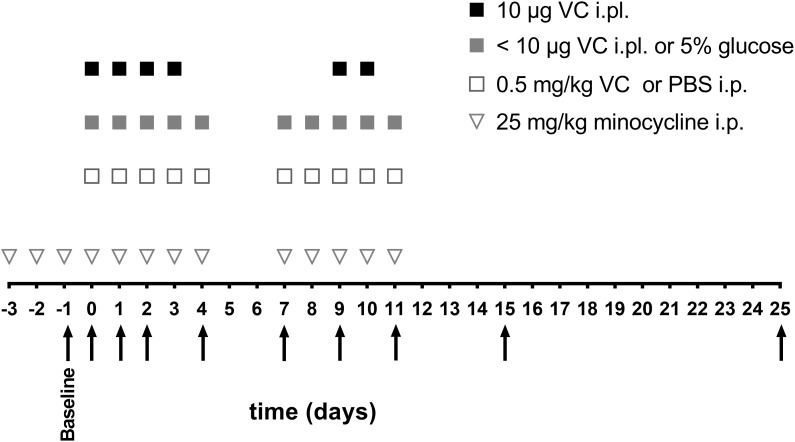
Schedule of vincristine injections and behavioral measurements. Vincristine (<10 μg i.pl. or 0.5 mg/kg i.p.) or vehicle (5% glucose i.pl. or PBS i.p.) (open square, gray square) were administered for five consecutive days, with 2 days break, followed by another five consecutive injections. The highest vincristine dose (10 μg i.pl.) (black square) was administered for four consecutive days, followed by 5 days break and another two injections. Minocycline (25 mg/kg i.p.) (open triangle) was administered once daily, 3 days before vincristine administration, and then with each vincristine injection. Arrows indicate the time points of behavioral assessments, which were always performed before the next vincristine injection with the exception of day 0, where behavioral assessment was performed 3 h after the first vincristine injection.